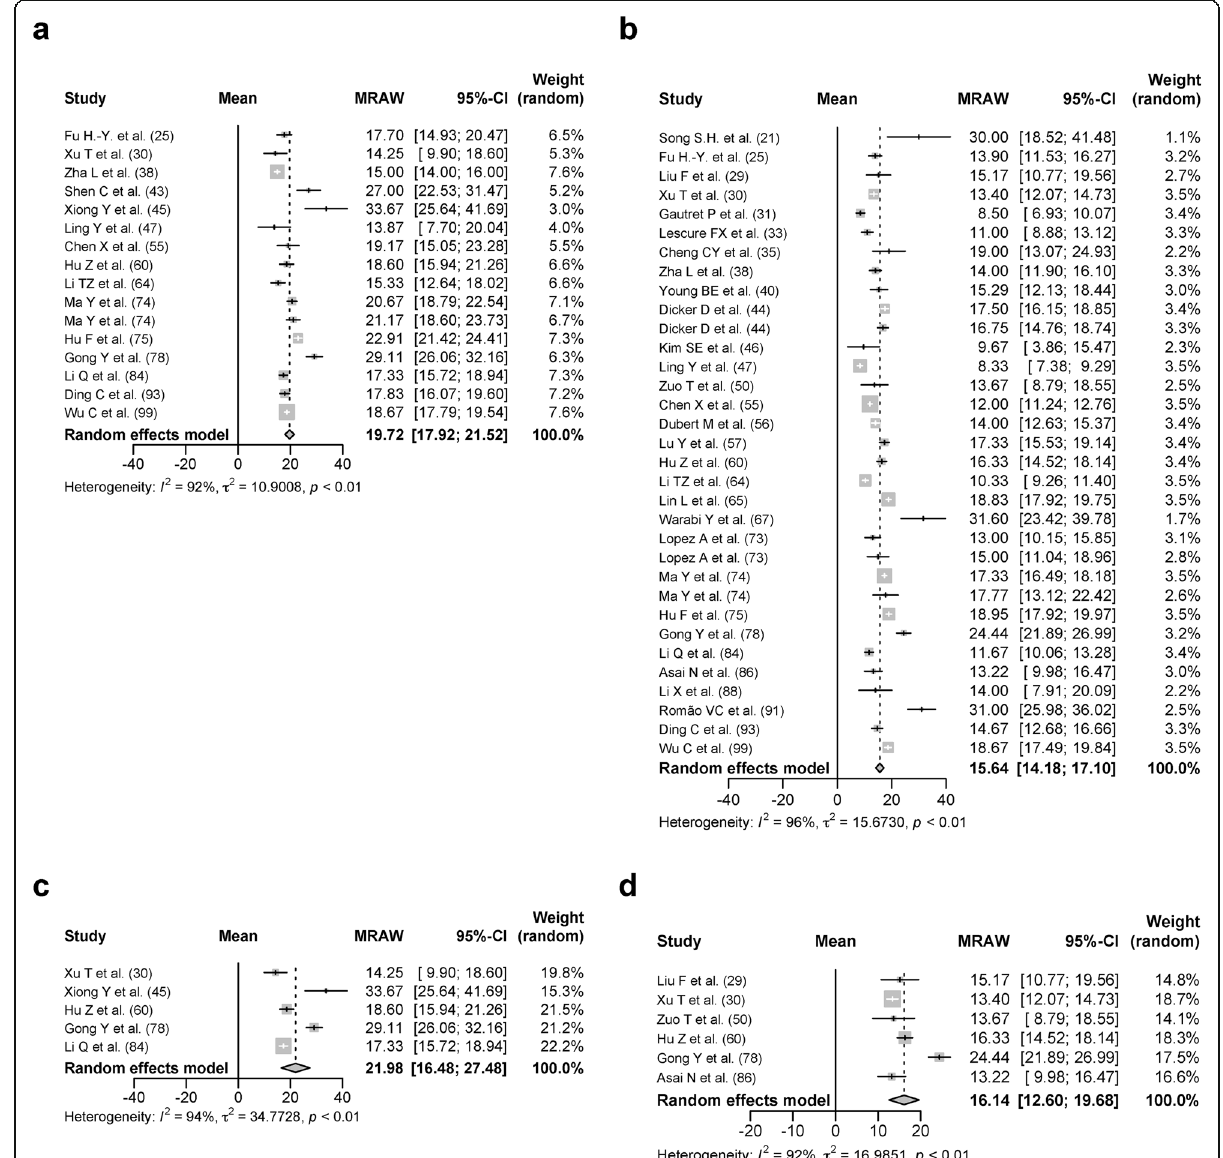
Fig. 8 Forest plot: a meta-analysis of the duration of SARS-CoV-2 RNA positivity in the upper respiratory tract samples based on the usage of glucocorticoid. The duration of SARS-CoV-2 RNA positivity from the onset of COVID-19 in the patients treated with glucocorticoid ( a ) and the patients treated without glucocorticoid ( b ) was calculated using the random effects model. The duration of SARS-CoV-2 RNA positivity from the onset of COVID-19 in the patients treated with glucocorticoid (c) and the patients treated without glucocorticoid ( d ) from the studies with the mean age of 30 – 60 years and the proportion of patients with any comorbidities of 50% or less was calculated using the random effects model. MRAW, the raw data of mean; 95%-CI, 95% confidence